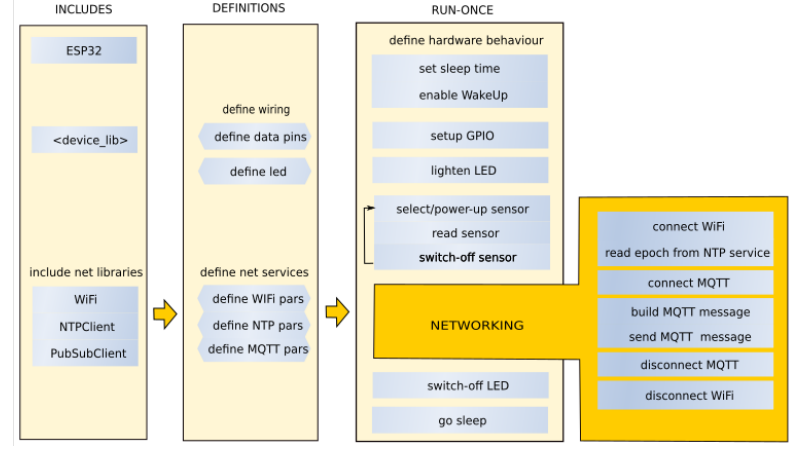
Figure 5. Flowchart of the code running on the ESP 32 controller .